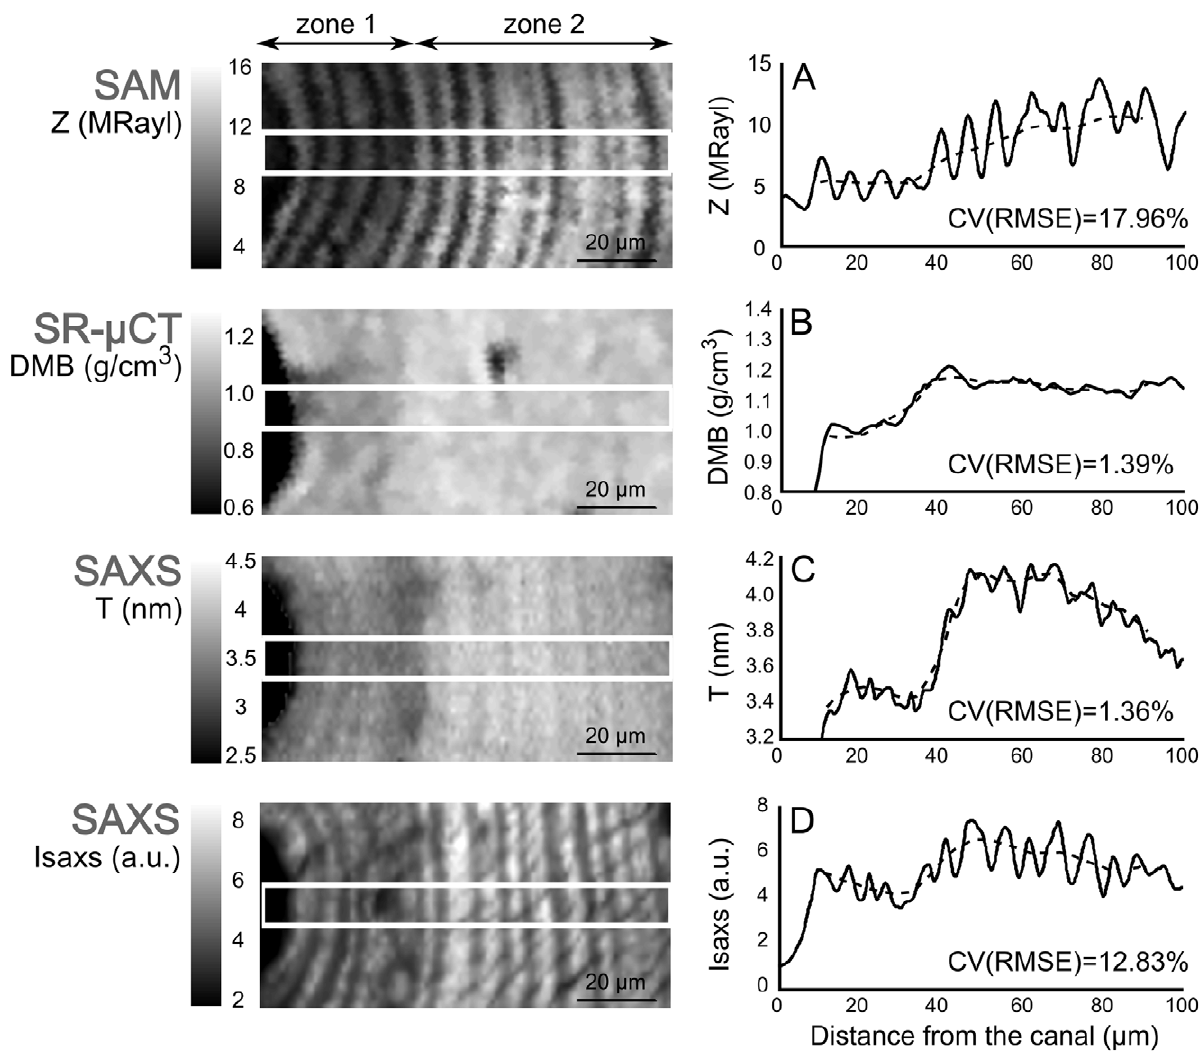
Figure 3. Comparison between local elastic properties and mineral ultrastructural characteristics. From top to bottom: A acoustic impedance ( Z ), B degree of mineralization of bone ( DMB ), C T -parameter linked to the mineral thickness, D I SAXS related to changes in the lamellar orientation (the results are illustrated for ost1 ). For each investigated parameter, the solid line represents its variations along a radial profile going from the Haversian canal to the outer lamellae. The dashed line represents the corresponding smoothed profile after averaging the values between adjacent peaks. The coefficient of variation of the root-mean-square error CV(RMSE) provides a measure of the relative amplitude fluctuations of the measured values around the averaged profile curves.